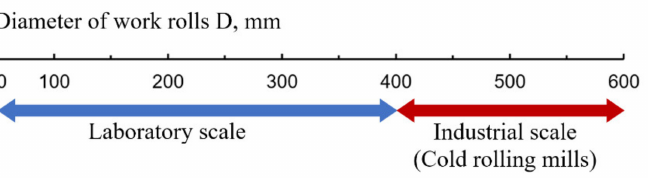
Figure 28. Diameter D (mm) of work rolls (cold rolling mills) at laboratory and industrial